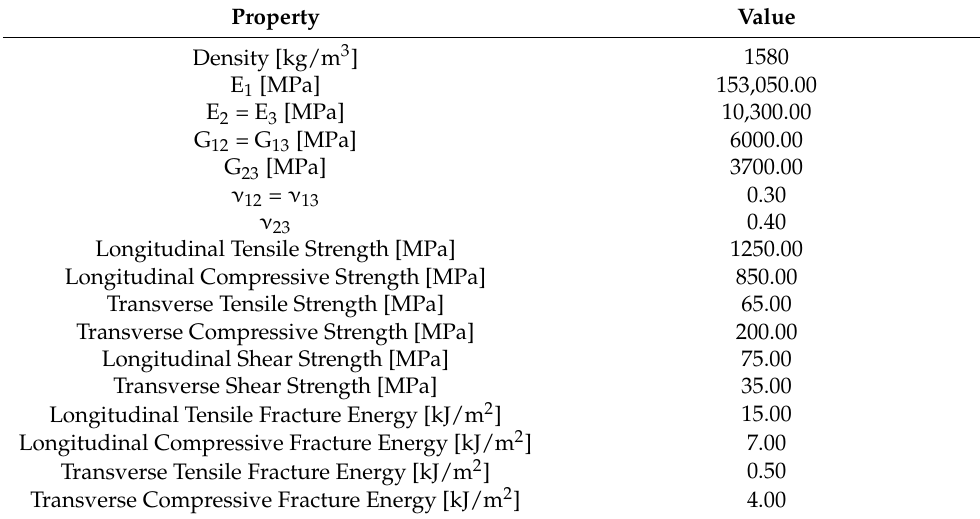
Table 1. Mechanical properties of IM7/977-2 composite material.